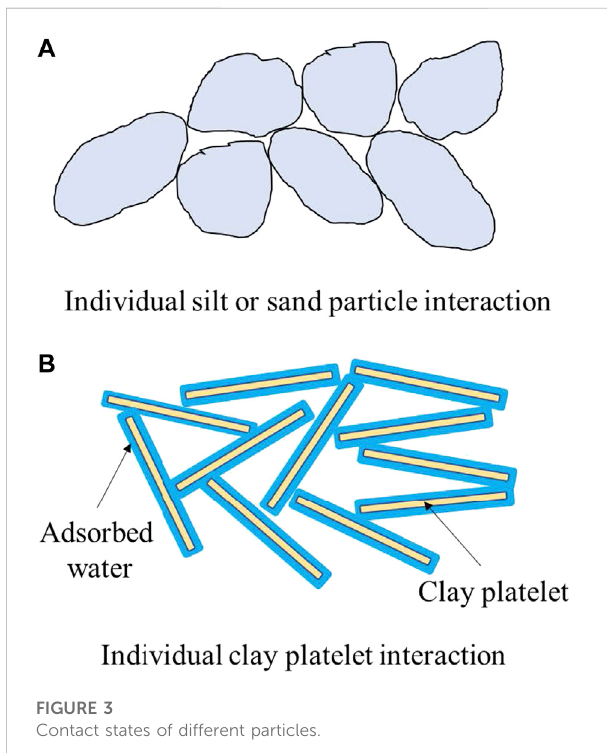
FIGURE 3 Contact states of different particles.